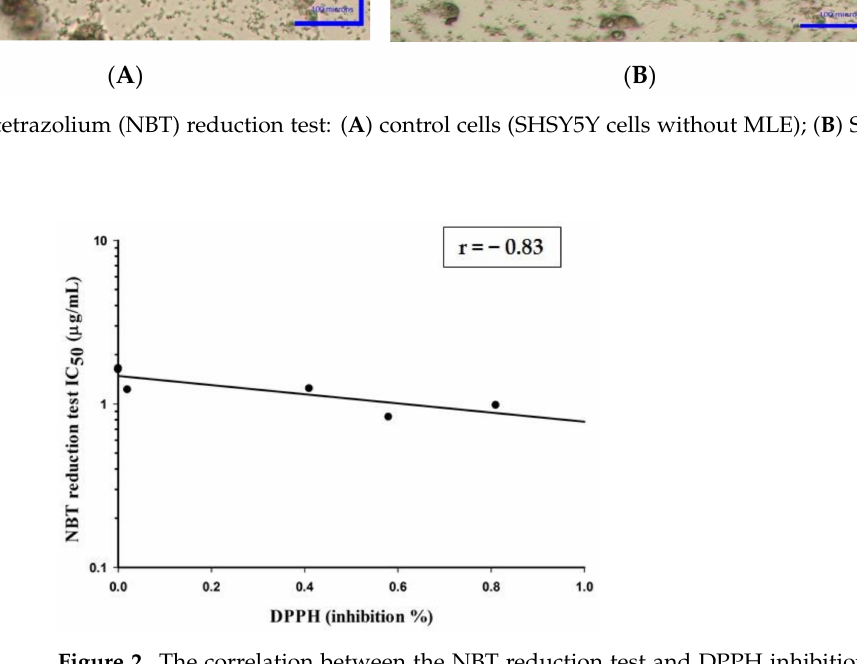
Figure 2. The correlation between the NBT reduction test and DPPH inhibition activity of plant extracts ( r = − 0.83, p <